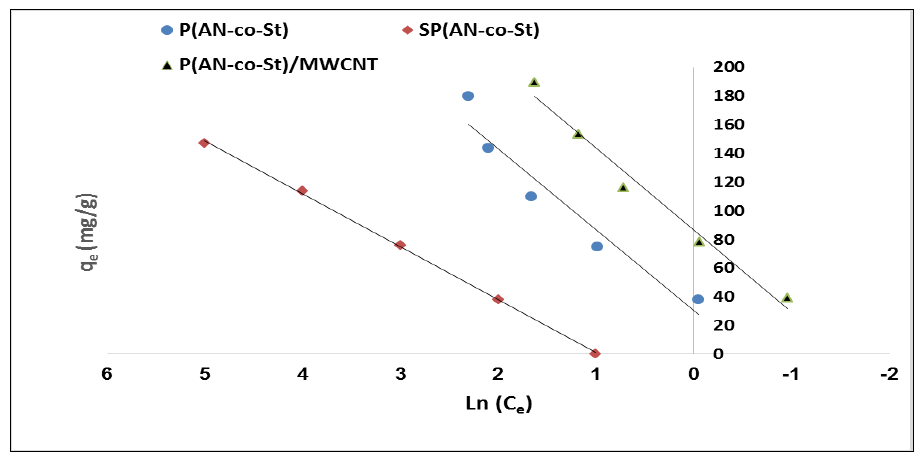
Figure 11. Freundlich plots for adsorption of MO onto different composites.